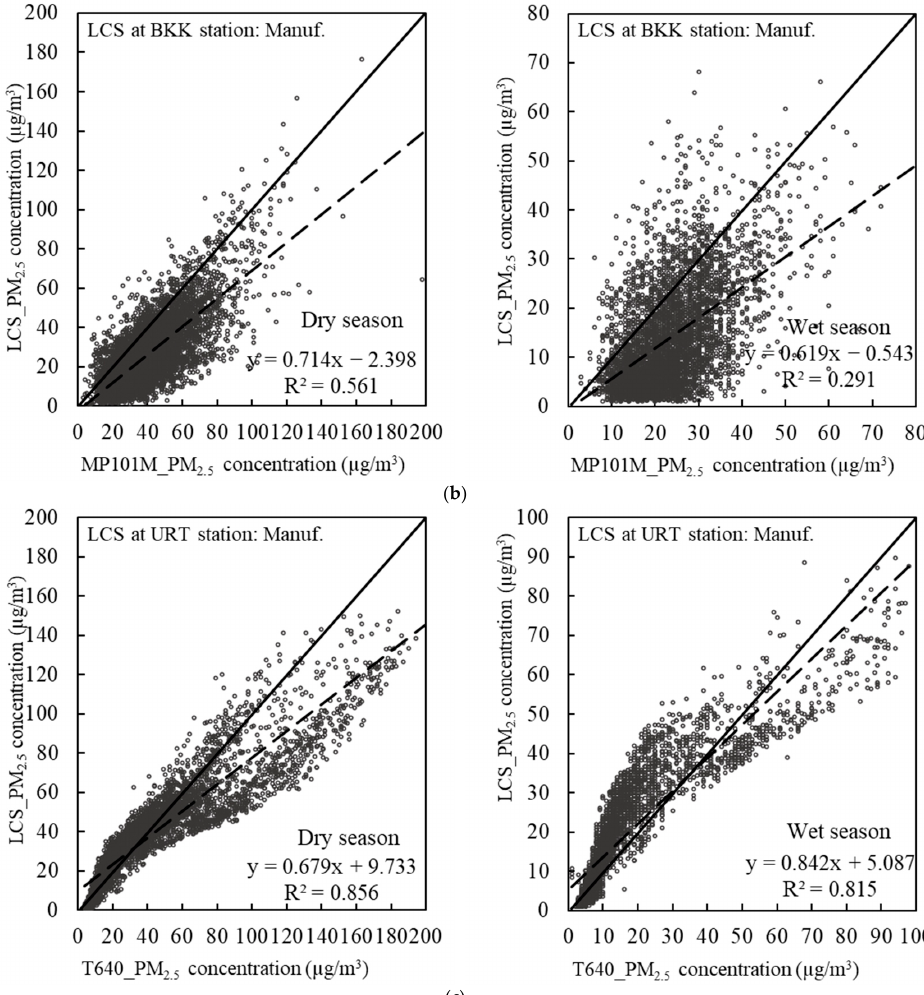
Figure 5. Comparison between 1-h PM 2.5 concentration between unadjusted LCS vs. FEM during the dry and wet seasons at ( a ) CM, ( b ) BKK and ( c ) URT. The solid line is the line with slope =1 while the dashed line represents the